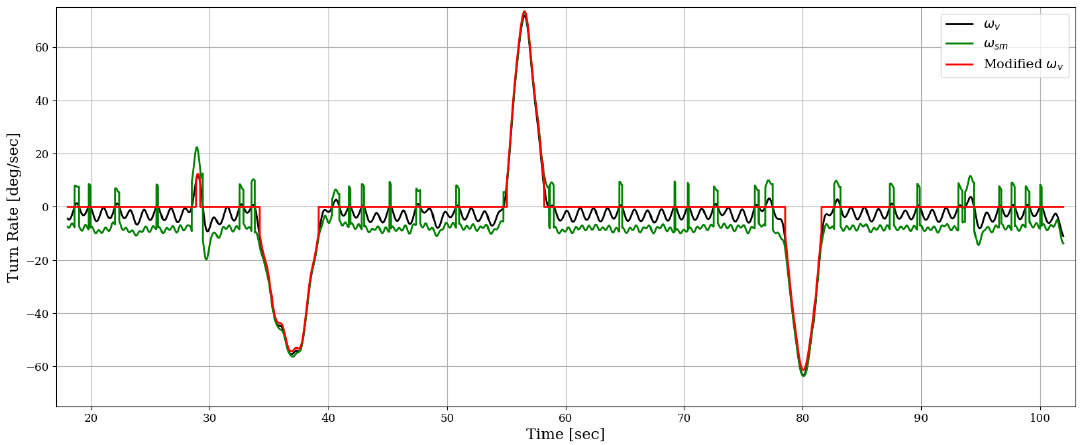
Figure 4. Comparing turn rate profiles as obtained by three gyroscope-based methods. The gravity direction here is estimated based on the accelerometer only.